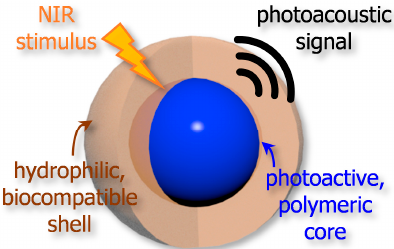
Figure 5. Illustration of general design concept for a core–shell-type, polymeric contrast agent for NIR photoacoustic imaging.